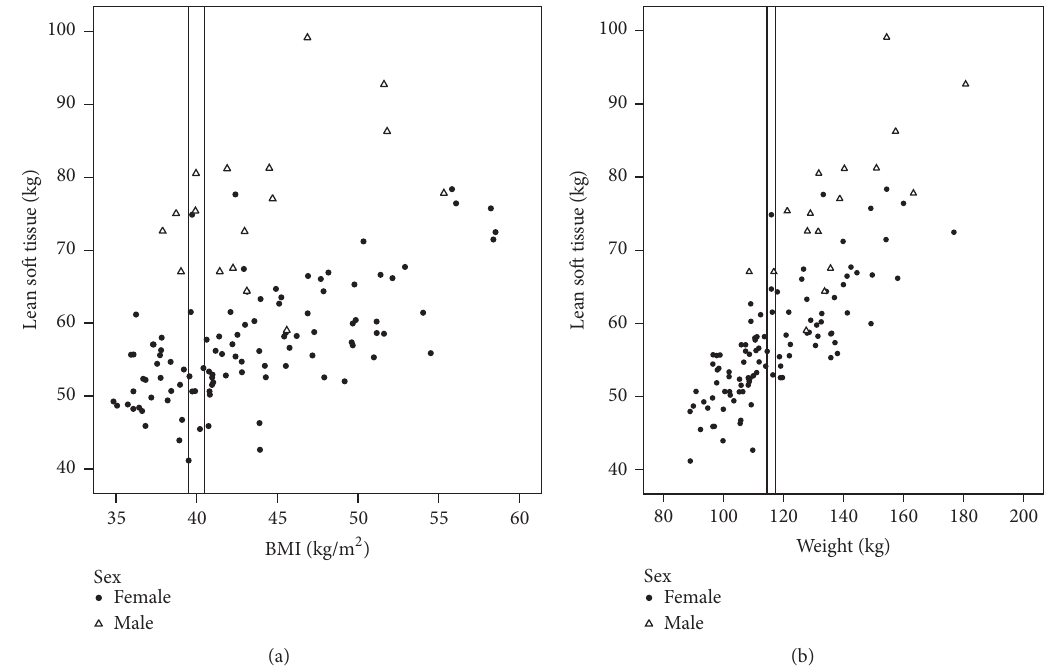
Figure 1: Variability of lean soft tissue by (a) body mass index (BMI) and (b) weight in adults with class II/III obesity ( 𝑛 = 120 , females = 103). The box illustrates selected examples of females with (a) the same BMI (40kg/m 2 ) but LST varying from 41.2 to 74.9 kg and (b) same weight (116kg) but LST varying from 52.9 to 74.9